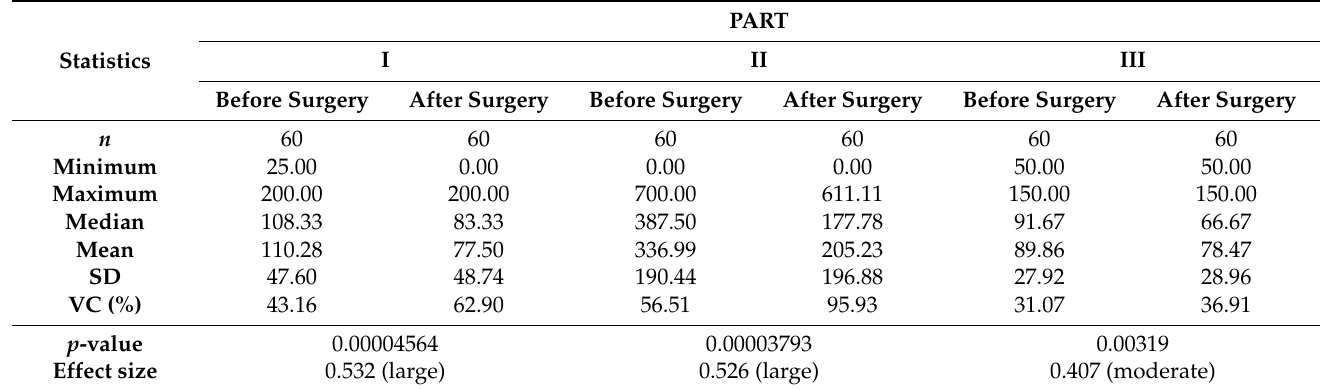
Table 4. KHQ parts for women before and 12 months after surgery.